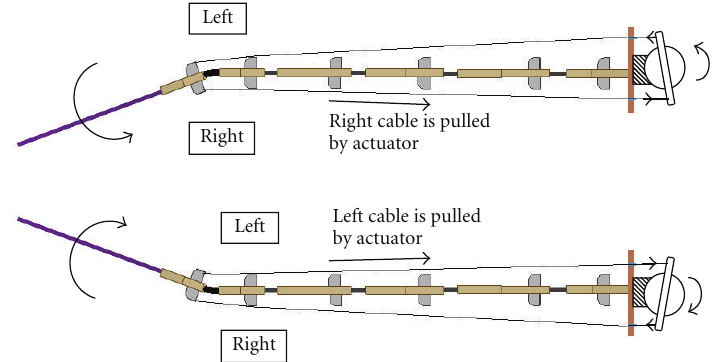
Figure 6: How the tail fin will respond as the actuator pull on the cables.